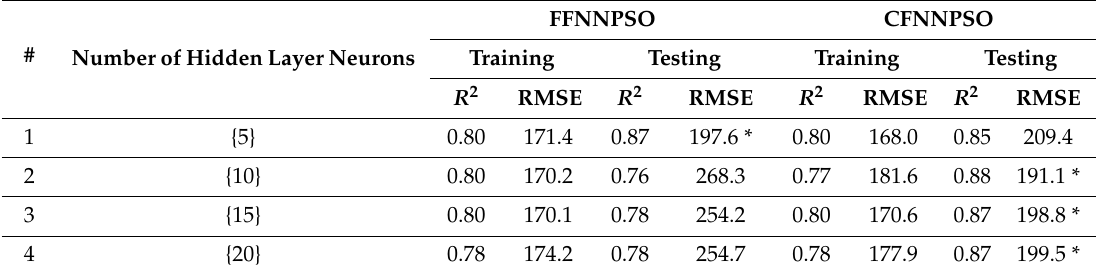
Table 7. Results on FFNN and CFNN trained using PSO with 3 features ( x 1 , x 2 , x 5